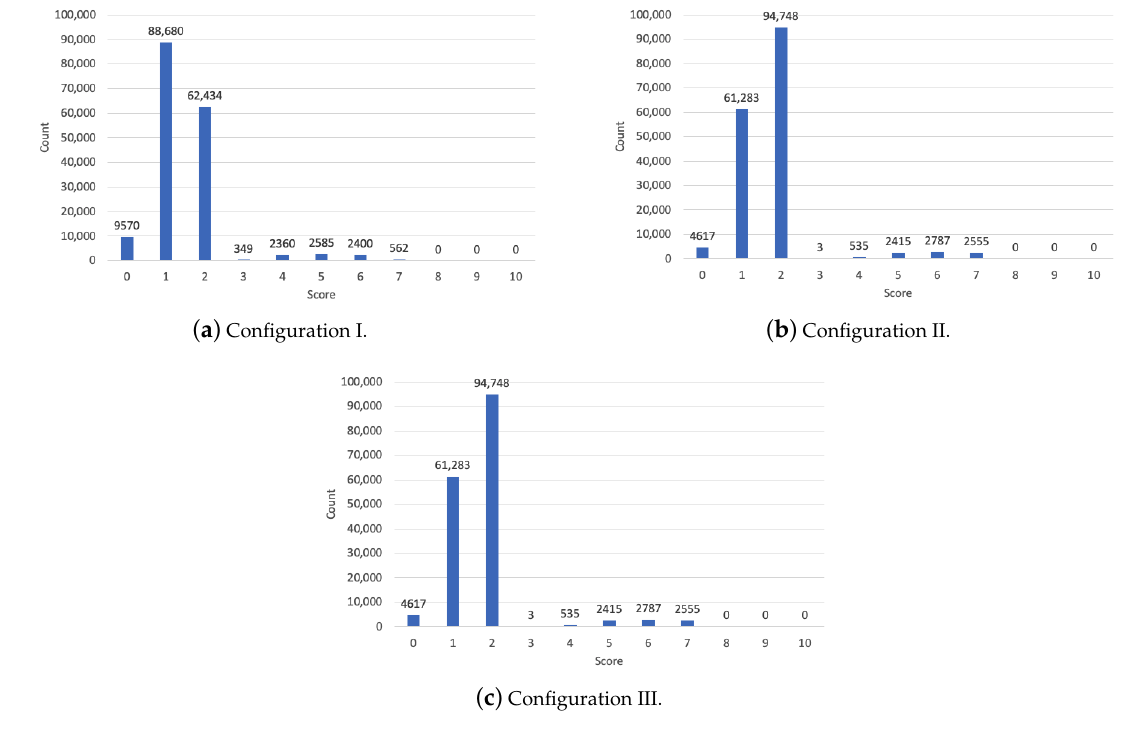
Figure 3. CVSS Environmental 2.0